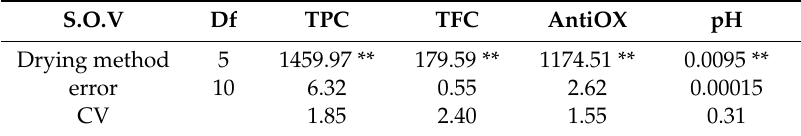
Table 5. Analysis of variance (ANOVA) for the e ff ect of drying methods on antioxidant capacity (AntiOX), total phenol content (TPC), total flavonoid content (TFC), and pH of terebinth.